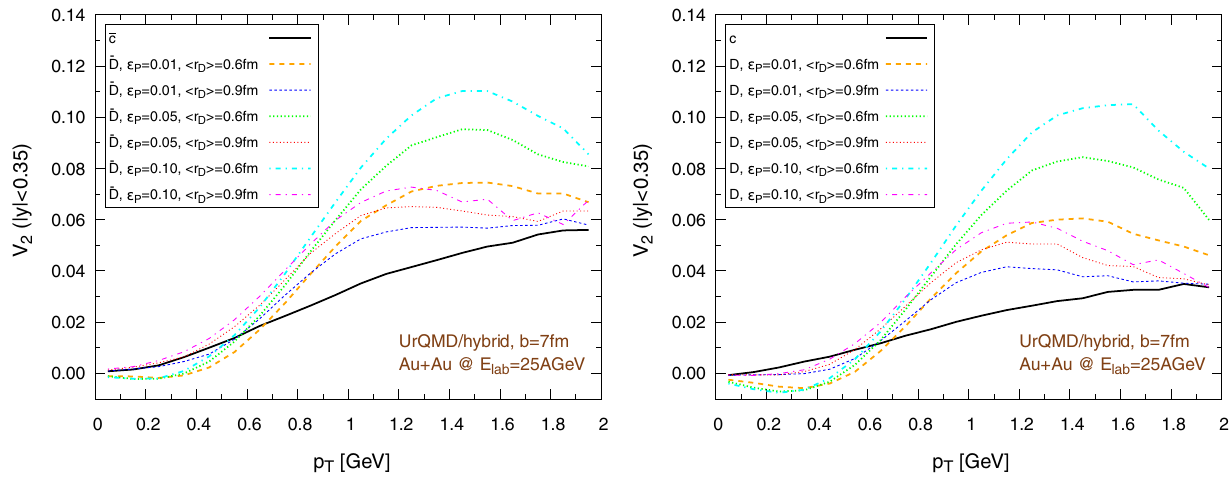
Fig. 24 Au+Au collisions at E lab = 25AGeV, b = 7fm in the UrQMD/hybrid model. Elliptic flow of charm quarks and D-mesons ( | y | < 0 . 35).Weexploretheeffectofdifferentchoicesofthehadroniza-